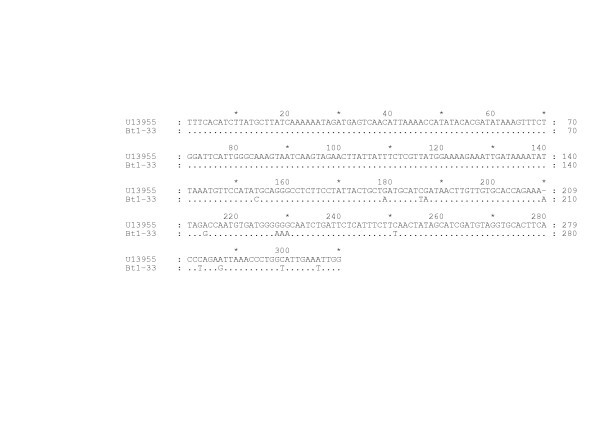
DNA sequence of PCR amplicon from Bt1-33. Comparison of the DNA sequence from Bt1-33 produced with the cry5 group primers and that of a known nematocidal gene, cry14Aa1 (GenBank accession number U13955). A "." is placed at those positions in Bt1-33 where the nucleotide is the same as that in U13955, and a letter denoting the nucleotide if it is not. Dashes "-" represent insertions required to align the sequences.